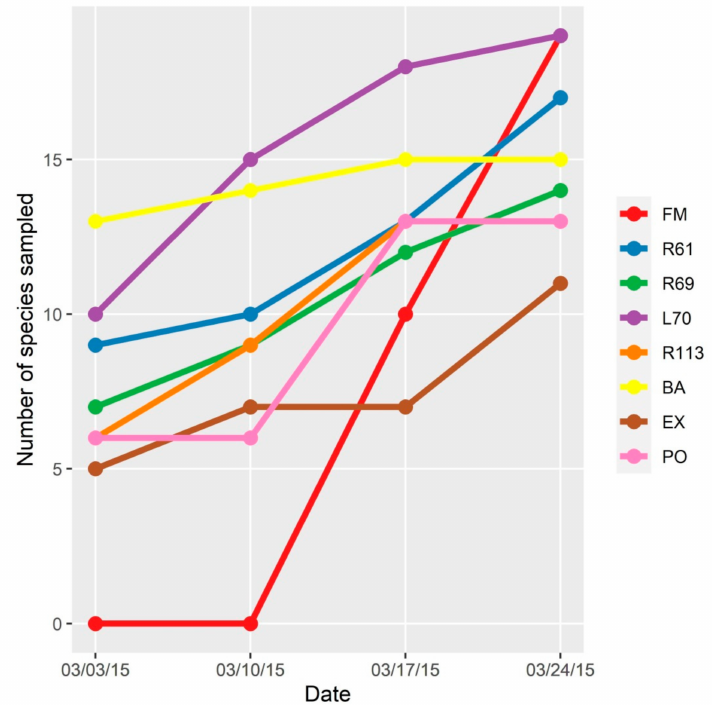
Figure 3. Accumulation curve of Culicidae species per sampling site in S ã o Paulo Zoo. Absolute number of species ( Y -axis) is shown in each point on the curve and the accumulation number of species on each week of collection (MM/DD/YY) ( X -axis). Table 3. Landscape metrics and its percentages (in brackets) in relation to the total area for each of the eight mosquito collection sites in S ã o Paulo